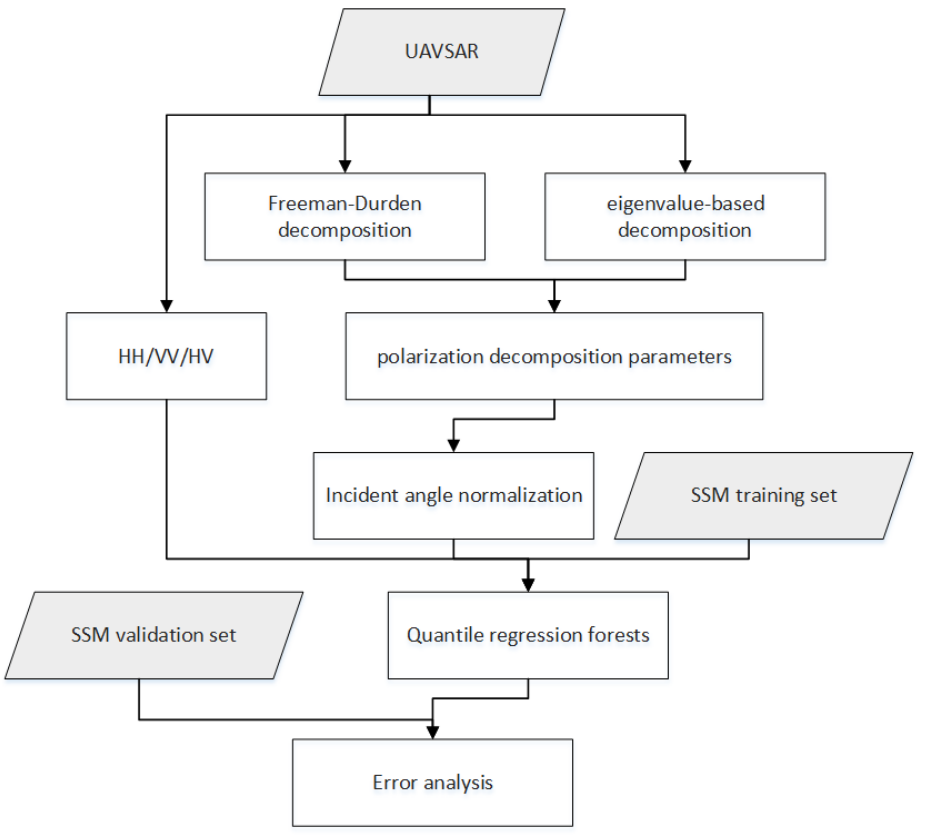
Figure 3. Flowchart of the algorithm for estimating soil moisture (SSM) from L-band UAVSAR data combining polarimetric decomposition and quantile regression forests